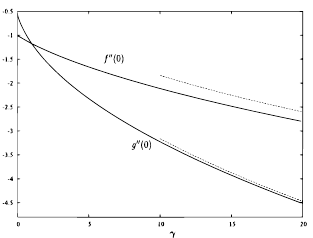
Figure 2. Impermeable surface, S = 0: plots of f (cid:48)(cid:48) (0) and g (cid:48)(cid:48) (0) against γ obtained from the numerical solution to equations (2.4)–(2.6). Asymptotic expressions (3.6) are shown by broken lines.